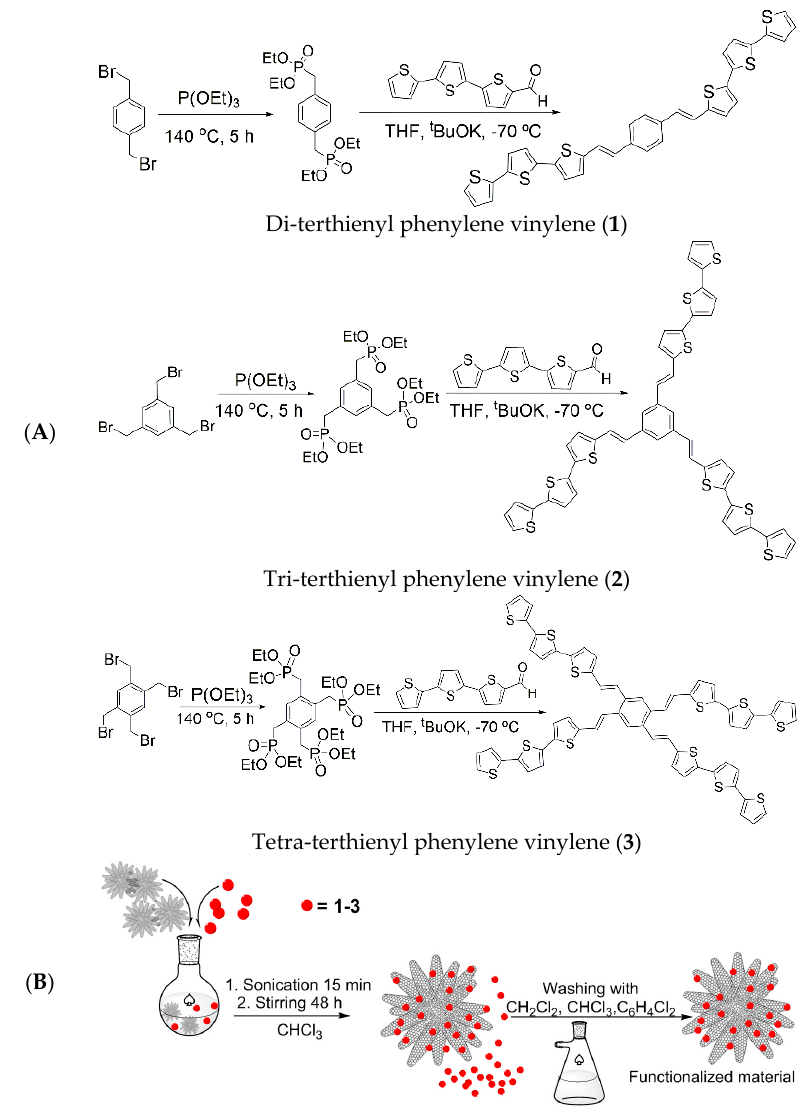
Figure 3. Synthetic route of CNH samples having adsorbed terthienyl dyes: ( A ) Synthesis of dyes ( 1 )–( 3 ) that will form non-covalent aggregates with CNHs; ( B ) pictorial illustration of the process used to attach the dyes to